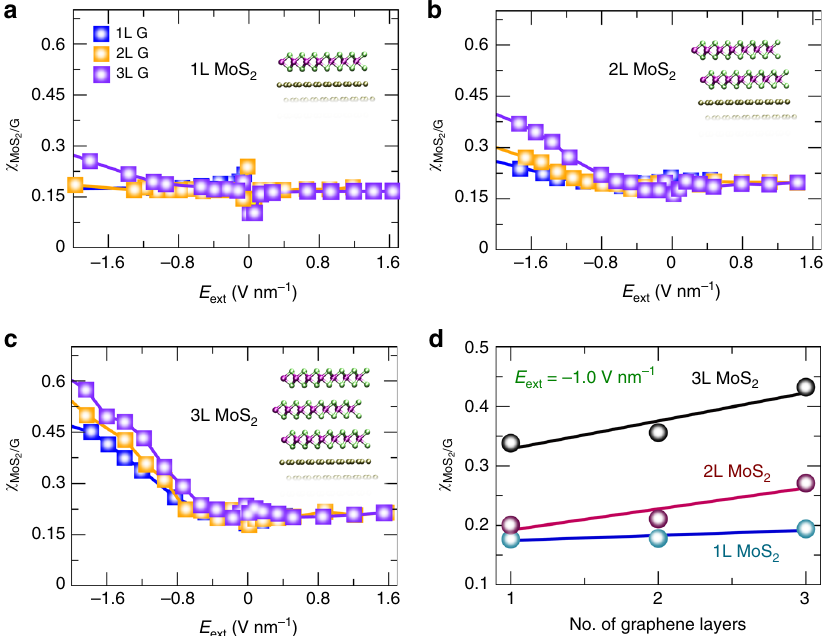
as a function of external electric G = MoS 2 fi xed